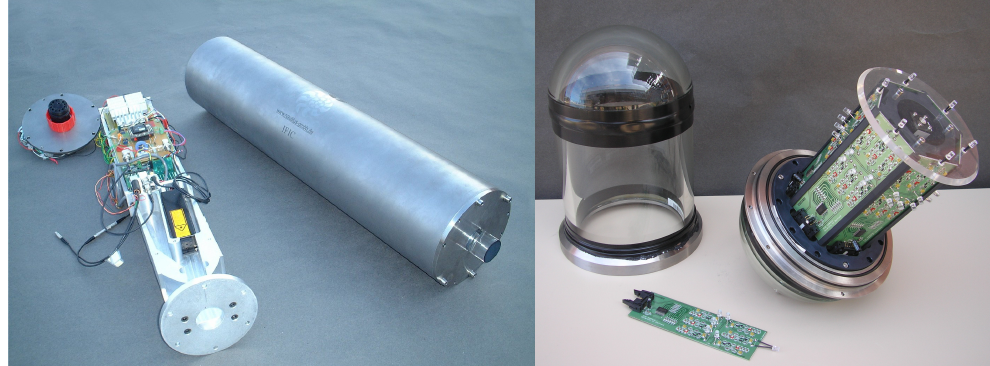
Figure 9. Detail of the laser beacon with the laser head, the power supply and the electronic control system ( left ) and LED optical beacon with its cylindrical pressure-resistant glass vessel ( right